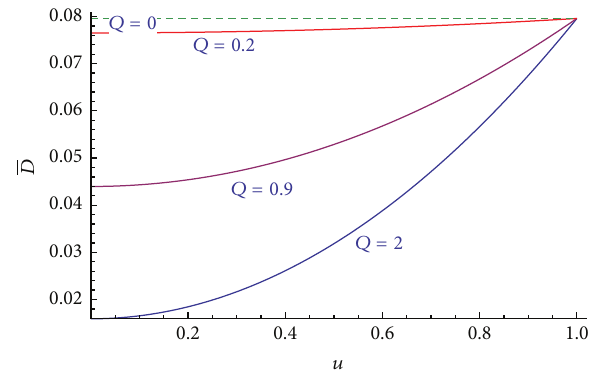
Figure 2: The dimensionless diffusion coefficient as a function of radial coordinate 𝑢 with 𝐿 = 𝑟 0 = 1 = 𝜅 2 = 1